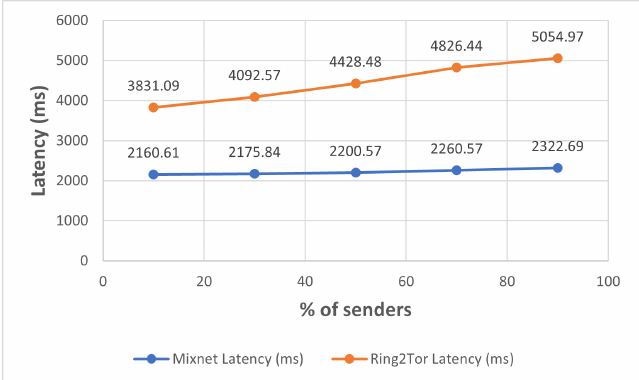
Figure 16. Latency vs. percentage of senders in mixnet and